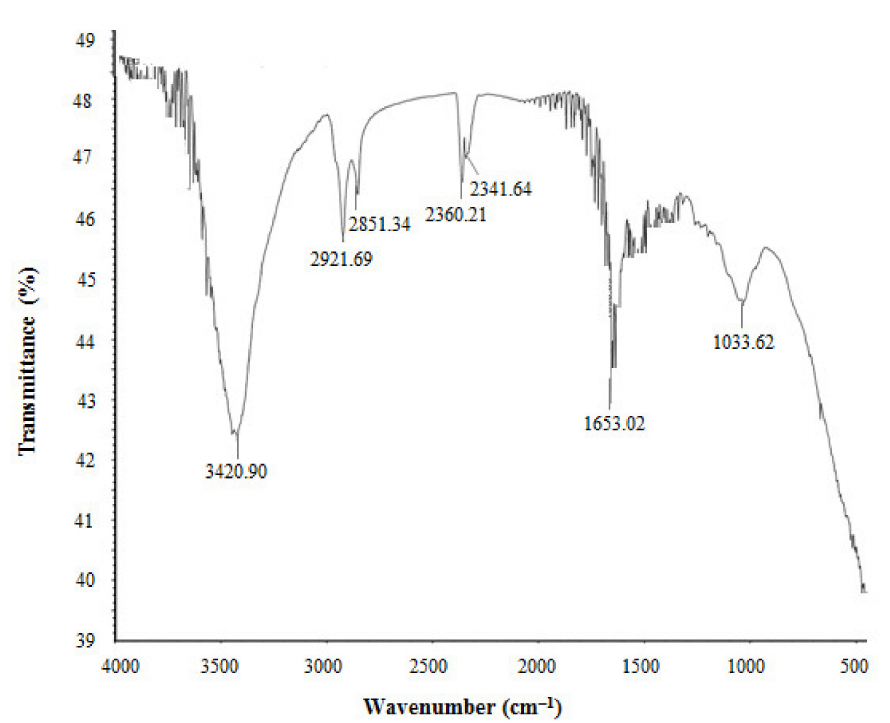
Figure 5. FT-IR spectra of P. nicotinovorans MAHUQ-43-mediated synthesized